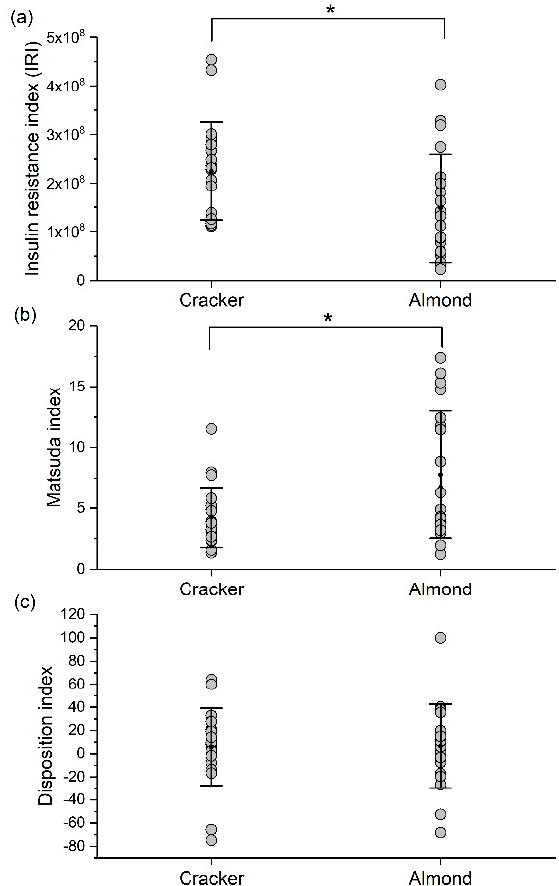
Figure 5. ( a ) Insulin resistance index (IRI), ( b ) Matsuda index and ( c ) disposition index during an OGTT in the cracker and almond groups at week 8 of the intervention. Values are individual data points representing each participant at each time point. Means ± SDs of the 2 snack groups at each time point are also plotted. Analysis for indices was conducted using a Kruskal-Wallis test with snack group as between-subject factor. *, p < 0.05. Cracker: n = 20, Almond: n = 20.